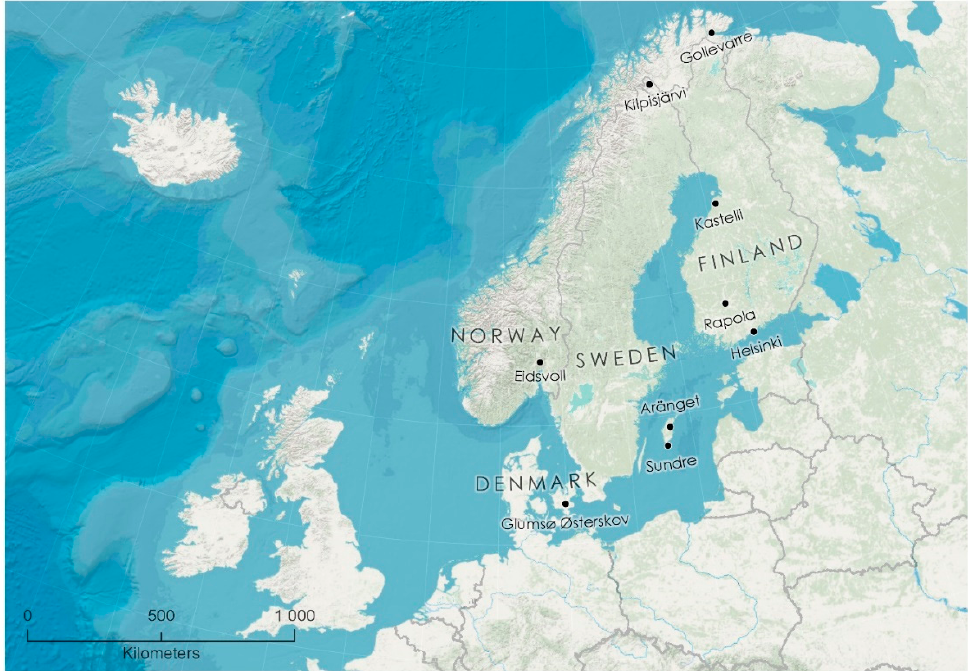
Figure 1. The Fenno-Scandinavian countries. The geographical positions of the sites presented in this article are indicated on this map. This is a matter of Eidsvoll: Figure 3, Glumsø Østerskov: Figure 4; Aränget: Figures 5 and 6; Kastelli, Kilpisjärvi, and Helsinki: Figure 7; Sundre: Figure 8 and Figure 9; Gollevarre: Figure 10; and Rapola; Figure 11. Illustration: Magnar Mojaren Gran, NTNU University